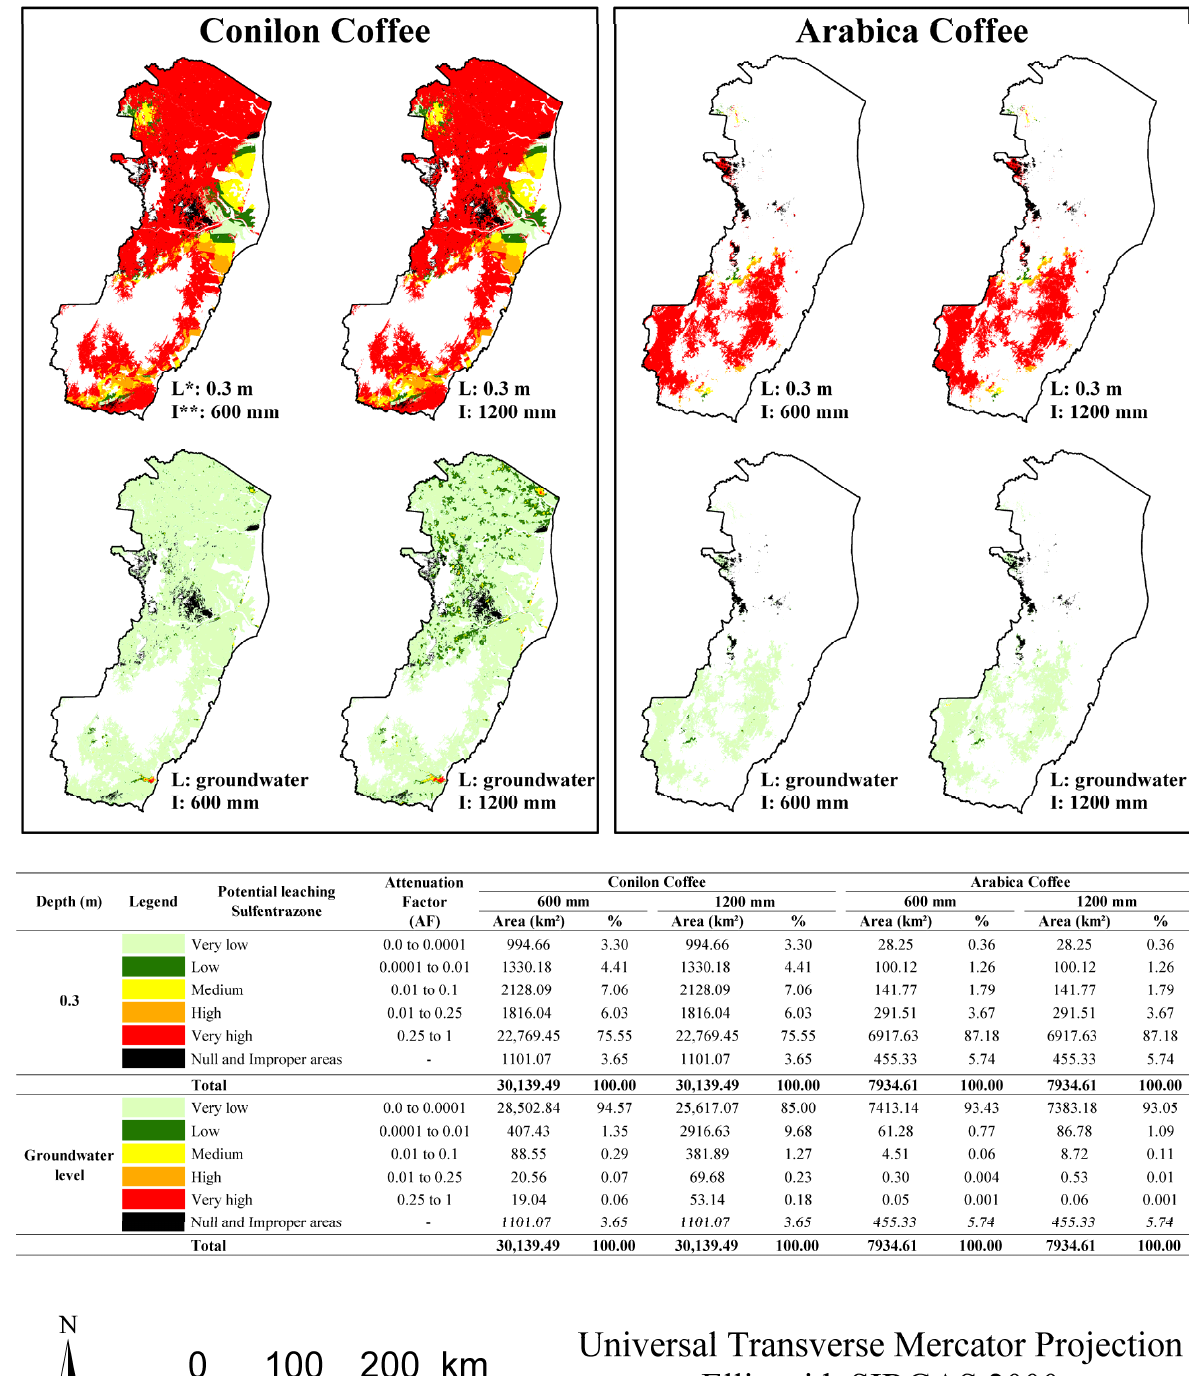
Figure 1. Attenuation Factor (AF) of active ingredient sulfentrazone evaluated for edaphoclimatically suitable areas for conilon ( Coffea canephora Pierre ex Froehner) and arabica ( Coffea arabica L.) coffee in Espírito Santo state, Brazil. * L: Groundwater depth and ** I: Irrigation.